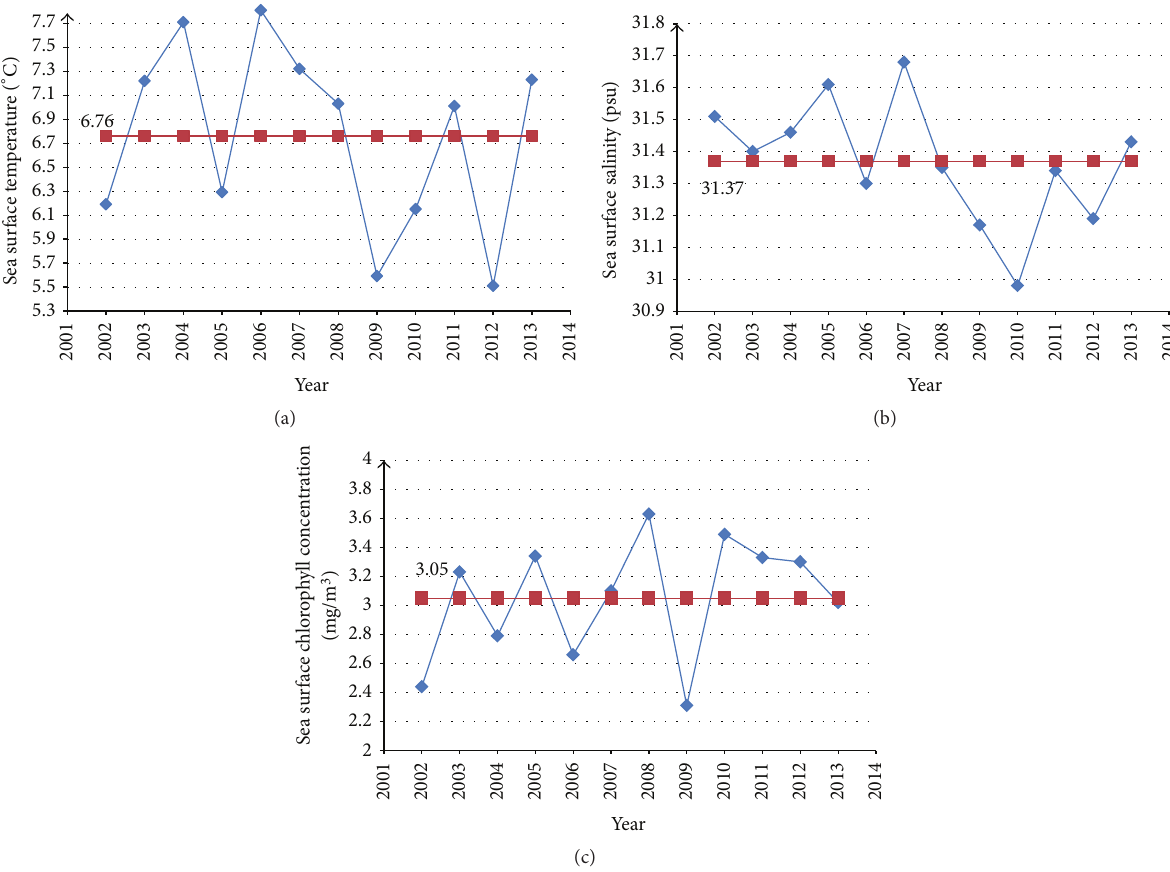
Figure 9: Average SST, SAL, and CHL in winter between 2002 and 2013. (a) Average SST; (b) average SAL; (c) average CHL.